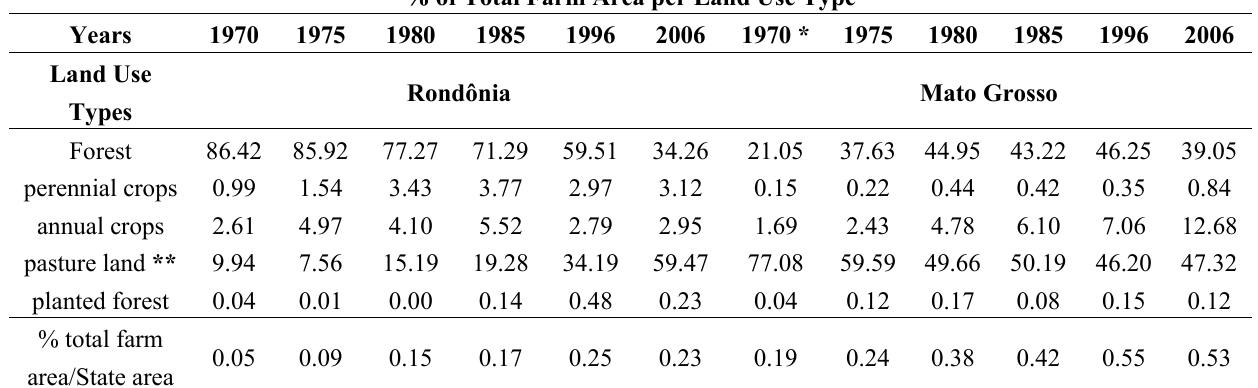
Table 1. Fractions of farm area under different land use types in Mato Grosso and Rondônia states based on Brazilian Agricultural Censuses from 1970, 1975, 1980, 1985, 1996 and